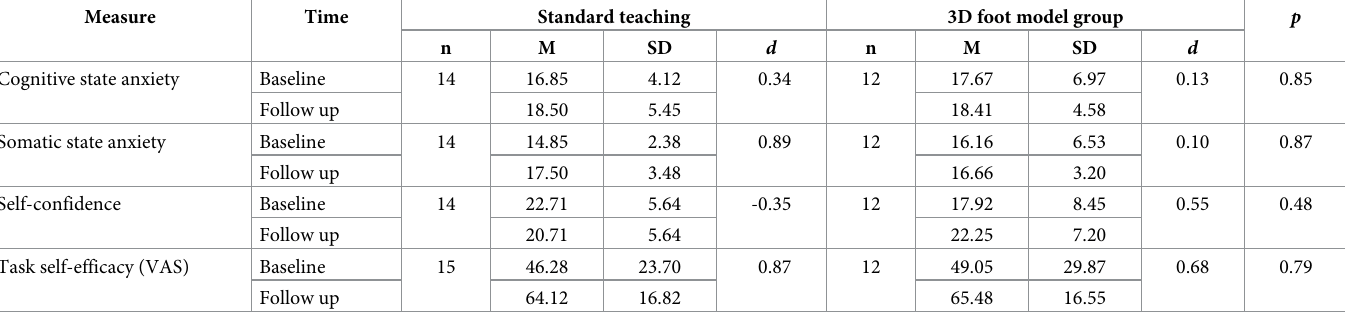
Table 4. Randomised control trial comparing anxiety and confidence (using the CSAI-2 and purpose-built questionnaire (VAS)) outcomes for standard teaching and the use of 3D printed foot models for 1-hr in second year students (2019 cohort).